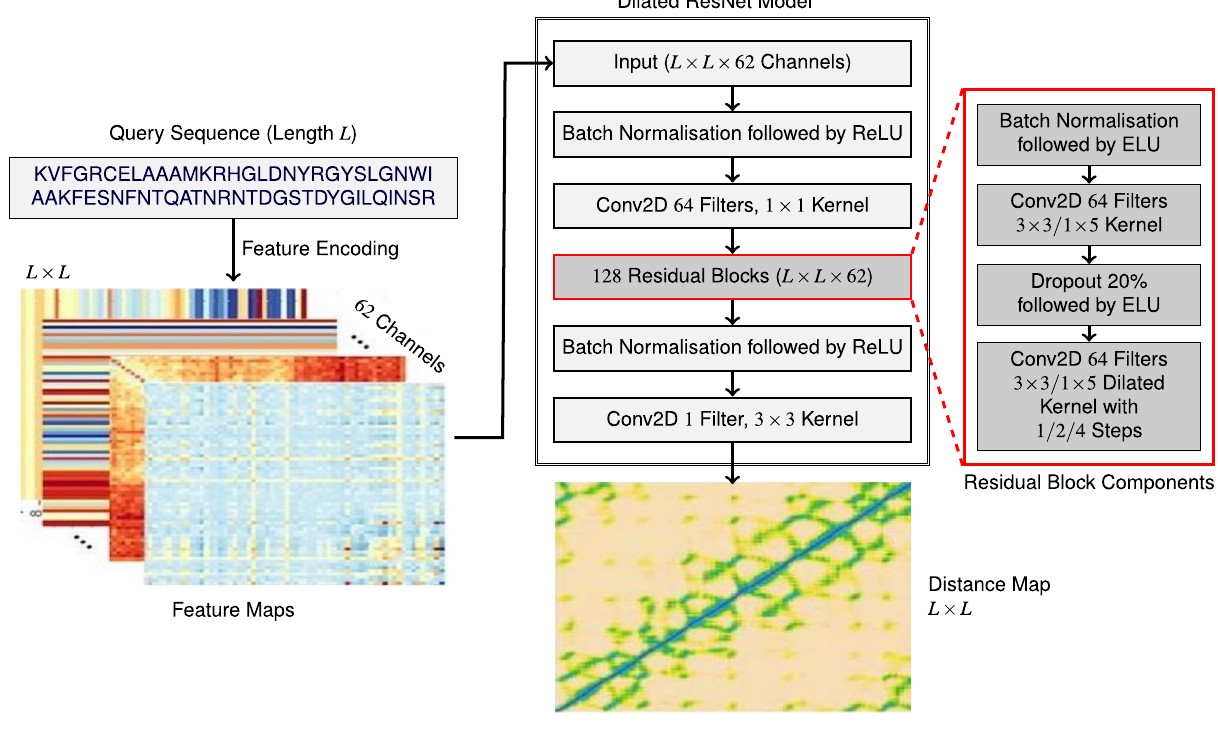
Figure 1. Our proposed dilated ResNet